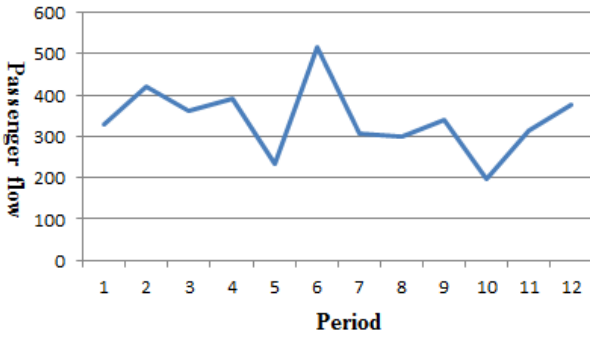
Figure 4. Passenger demand forecasting value